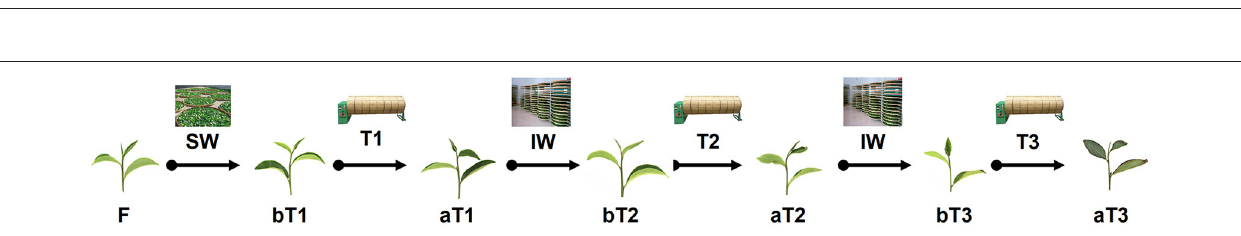
FIGURE 2 | Schematic diagram of sampling points before and after each turnover treatment. F, fresh tea leaves. bT1–bT3, process tea samples before each turnover treatment. aT1–aT3, process tea samples after each turnover treatment. Indoor withering was performed for 30min between each turnover